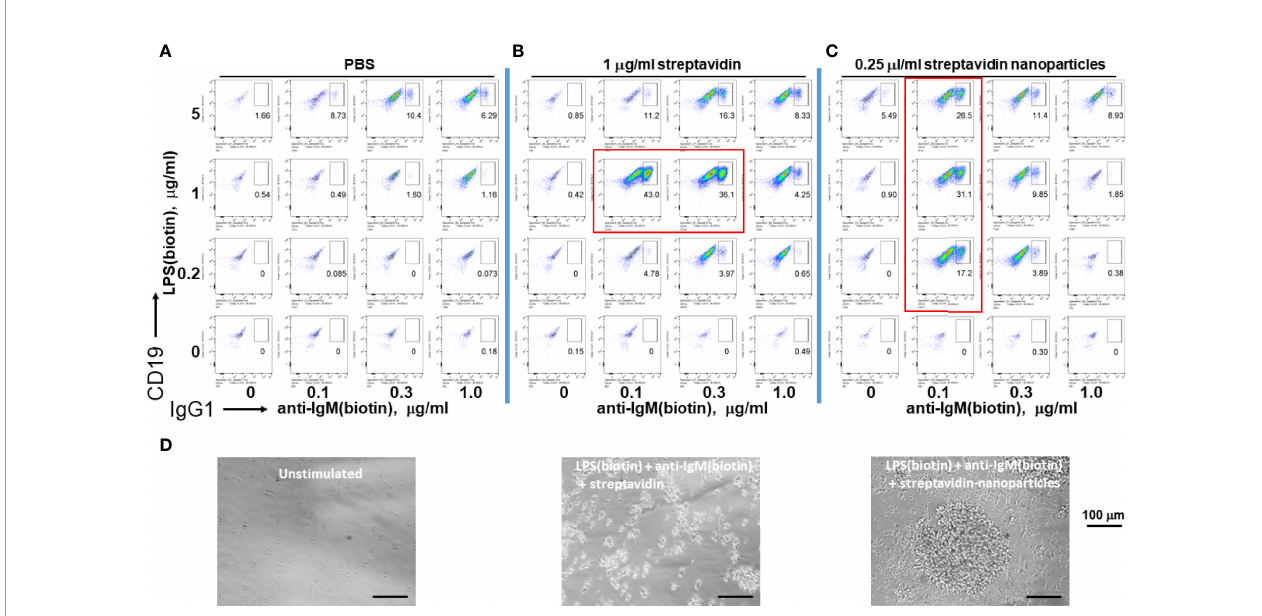
FIGURE 3 | Assembly of immunoconjugates by either soluble streptavidin or streptavidin nanoparticles yields dose-dependent CSR. Since microorganisms like viruses and bacteria are nanometer to micron sized, soluble streptavidin or polystyrene nanoparticles (~ 100 nm in diameter) conjugated with streptavidin on their surface were used to conjugate biotinylated LPS and anti-IgM. (A) Biotin-anti-IgM was titrated in indicated amounts along the x-axis vs biotin-LPS along the y-axis in the wells of a V-bottom 96 well polypropylene plate for 2 hrs at rt. Each well was then added to the corresponding well of resting murine splenocytes (2.5 x 10 5 cells/ ml in each well) in RPMI-FBS plus BME containing 25 ng/ml IL-4. Cells were stained following our typical fl ow cytometry protocol (Methods) and the fl uorescence of IgG1 vs CD19 were plotted. (B) Biotinylated anti-IgM F(ab ’ ) 2 and biotinylated LPS were fi rst mixed together in individual wells of a V-bottom polypropylene plate, and then 0.25 m g/well (equivalent to 1 m g/ml in a 250 m l RPMI-FBS cell culture) streptavidin in DPBS was added in a fi nal volume of 20 m l. (C) Streptavidin-conjugated polystyrene nanoparticles (~ 100 nm in diameter, Bangs labs) at 0.06 m l/well were added to premixed biotin-anti-IgM + biotin-LPS prior to each well being added to splenocyte cultures for 4 days prior to fl ow cytometry as before. (Preliminary studies tested these nanoparticles over a range of concentrations and found that they are not toxic to cells up to 0.25 m l/well). It is notable that both soluble streptavidin and streptavidin nanoparticles greatly enhance CSR to IgG1, but do so only at certain narrow combinations (plots within red rectangles) of biotinylated stimuli to streptavidin/streptavidin nanoparticles. (D) Phase contrast microscope images (20X) of unstimulated cells (left panel), splenocytes stimulated with conjugates of LPS(biotin), anti-IgM(biotin) and streptavidin coated nanoparticles (middle panel), or LPS (biotin), anti-IgM(biotin) and soluble streptavidin (right panel). Scale bar length is 100